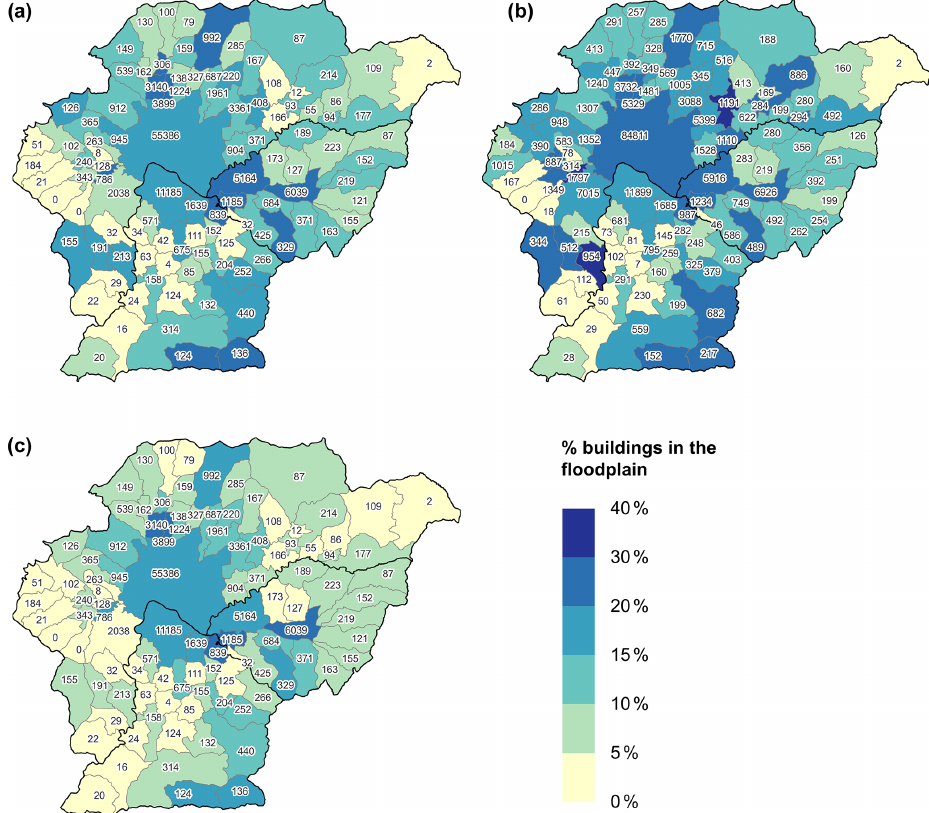
Figure 8. Spatial distribution of buildings in the 1000-year floodplain for (a) Scenario A, (b) Scenario B, and (c) Scenarios C and D. The numbers plotted inside each municipality correspond to the expected number of buildings in the floodplain.